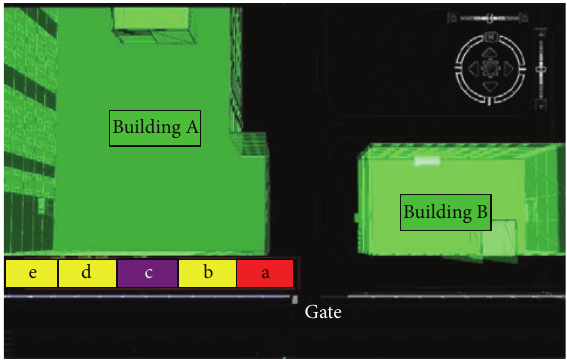
Figure 9: The placement of static and PTZ